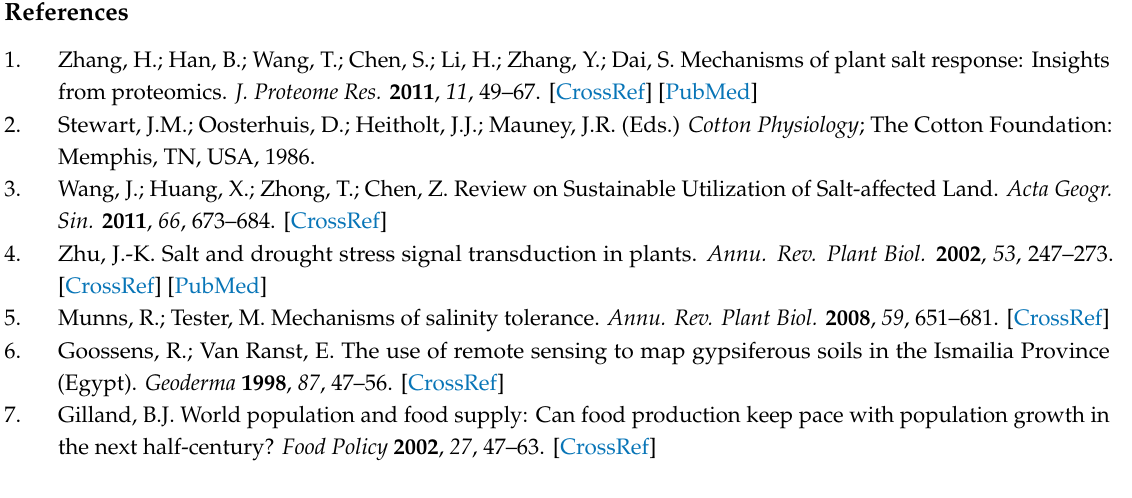
Figure S1: Gaussian distribution, Figure S2: Quantile Quantile plots, Table S1: list of cotton accessions used in this study, Table S2: cumulative variance, Table S3: factor scores, Table S4: List of primer